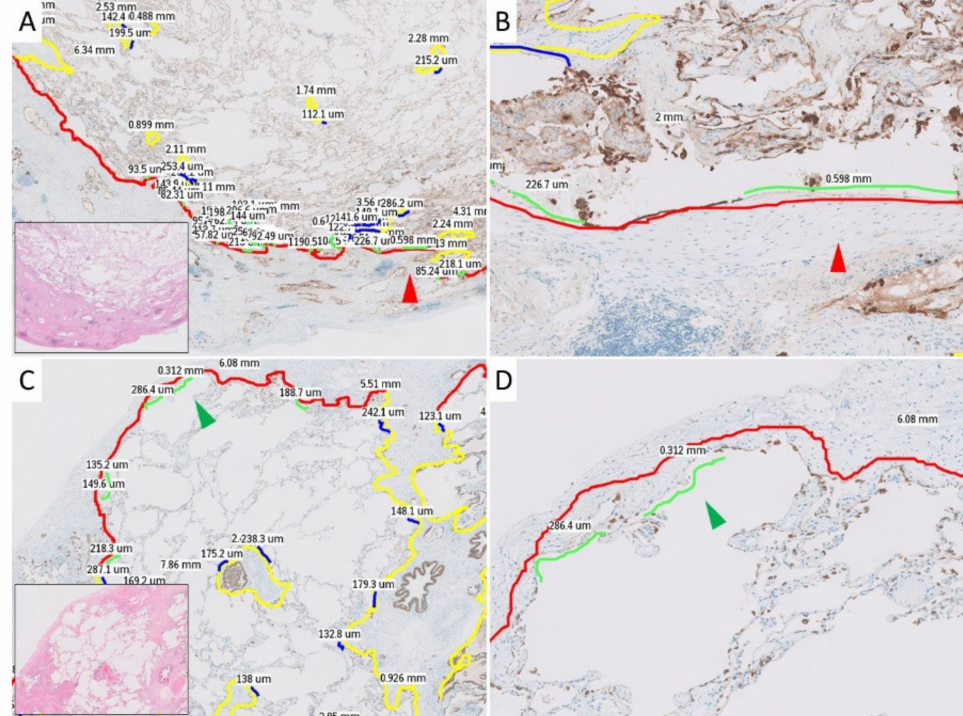
Figure 1. Histopathological images with annotations used in the current study. The red and green arrowheads each indicate the same location. The details of the colors in the annotation lines are as follows: red, subpleural zone; yellow,